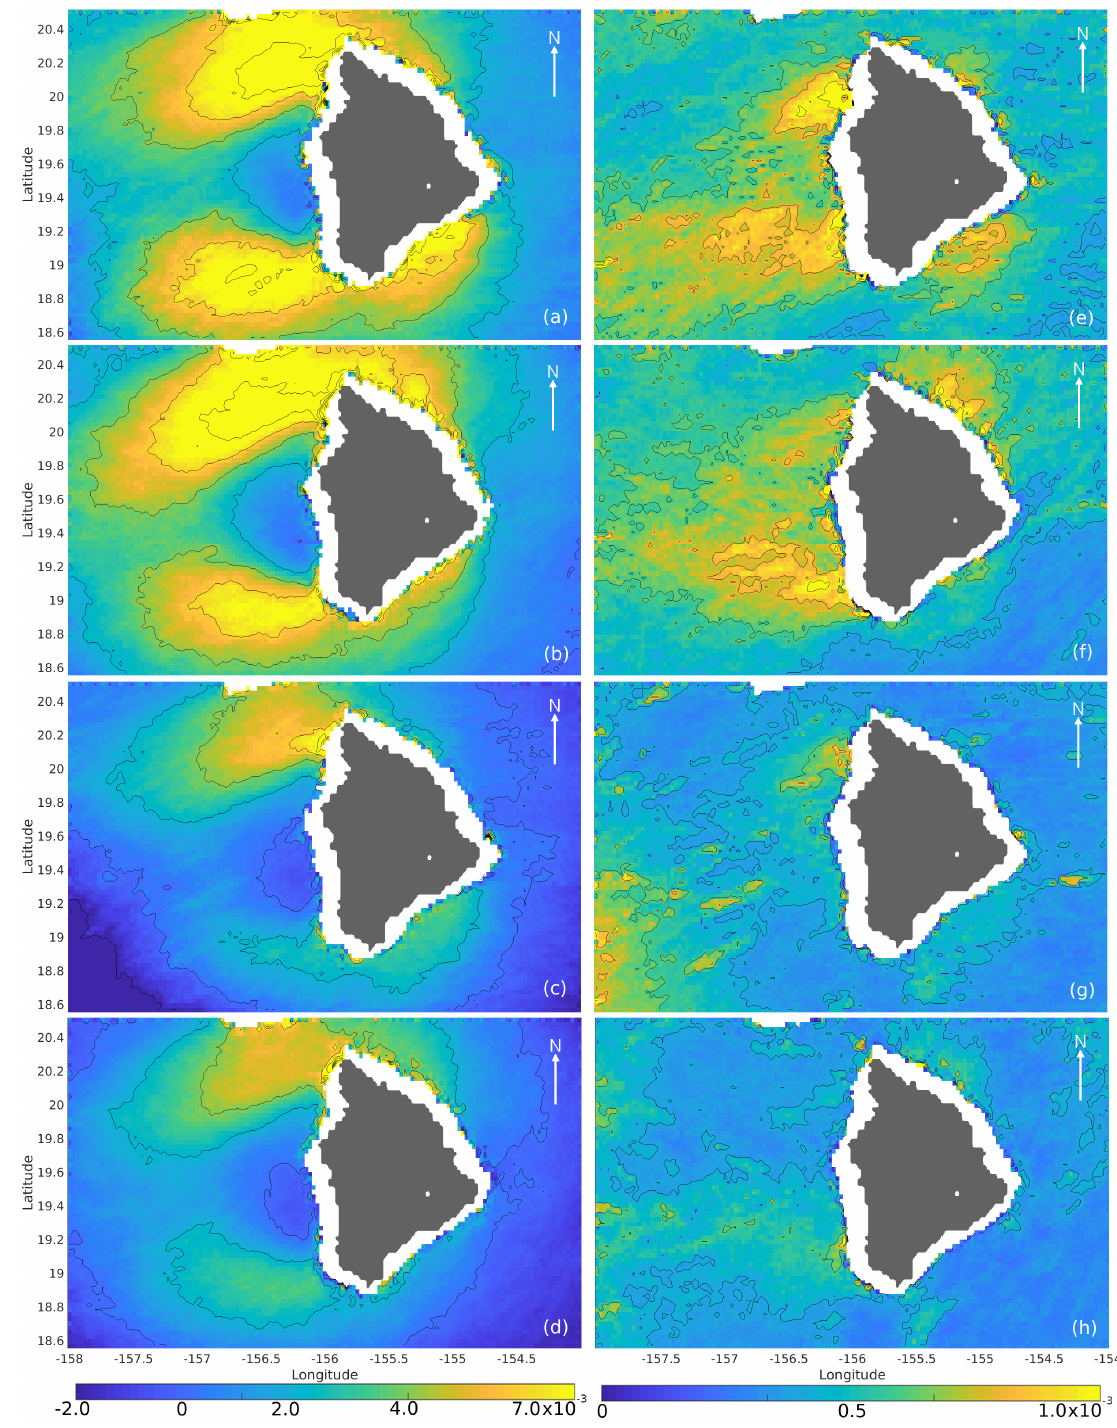
Figure 6. Panels ( a – d ) show the average difference in linear values between measured QuikSCAT σ 0 and NWP predicted σ 0 for different flavors of σ 0 ; ( e – h ) show the normalized standard deviation in linear values between measured QuikSCAT σ 0 and NWP predicted σ 0 . The first row is VF, second is VA, third HF, and the fourth row HA. The land is shown in gray and the land contamination buffer is shown in